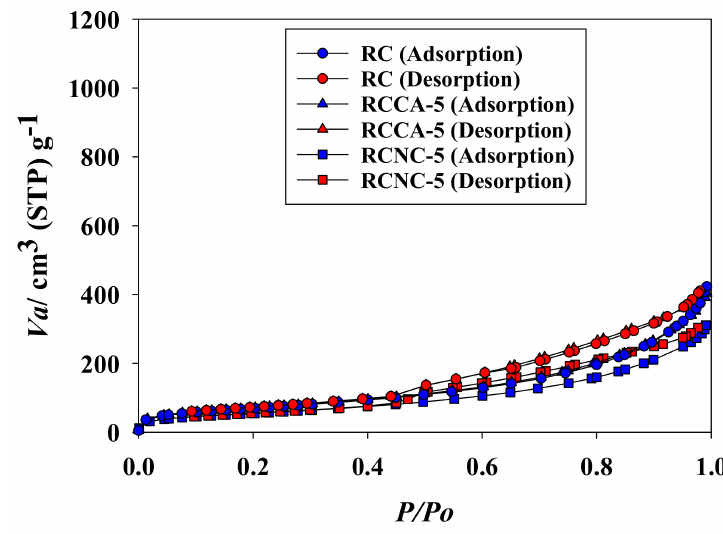
Figure 8. Nitrogen gas adsorption and desorption isotherms of composite aerogel beads after adsorption of Cd 2+ ions.